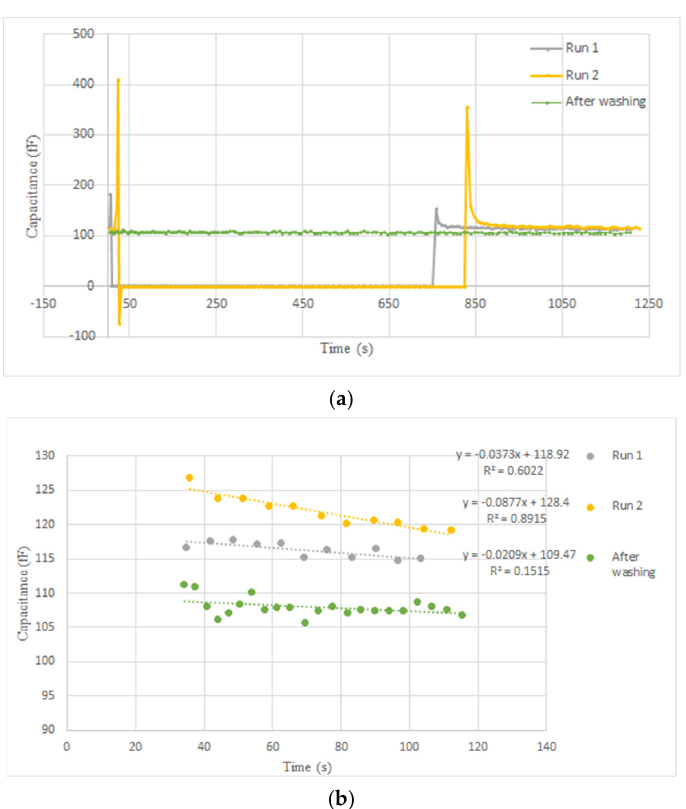
Figure 19. The microscopic images of the surface of the chip for the second experiment: ( a ) After washing and before Run 1; ( b ) After putting the first sample (Run 1); ( c ) After putting the second sample (Run 2); ( d ) The cleaned surface after Run 2. The capacitance was extracted according to the algorithm explained in Section 3.4.4. Figure 20a,b show the capacitance variations versus time. Real-time measurement of the output during these two trials and after the washing procedure results in three groups of 3D profiles, as shown in Figure 21. Each group includes two 3D profiles for the two elec- trodes on the left and right.